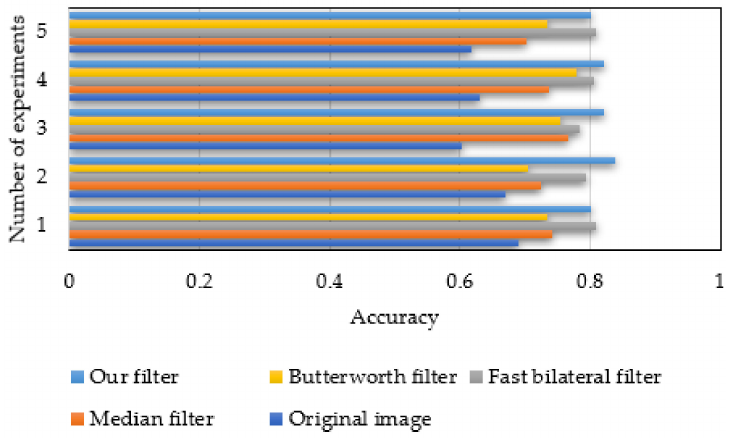
Figure 22. Accuracy of different filters on the test set.